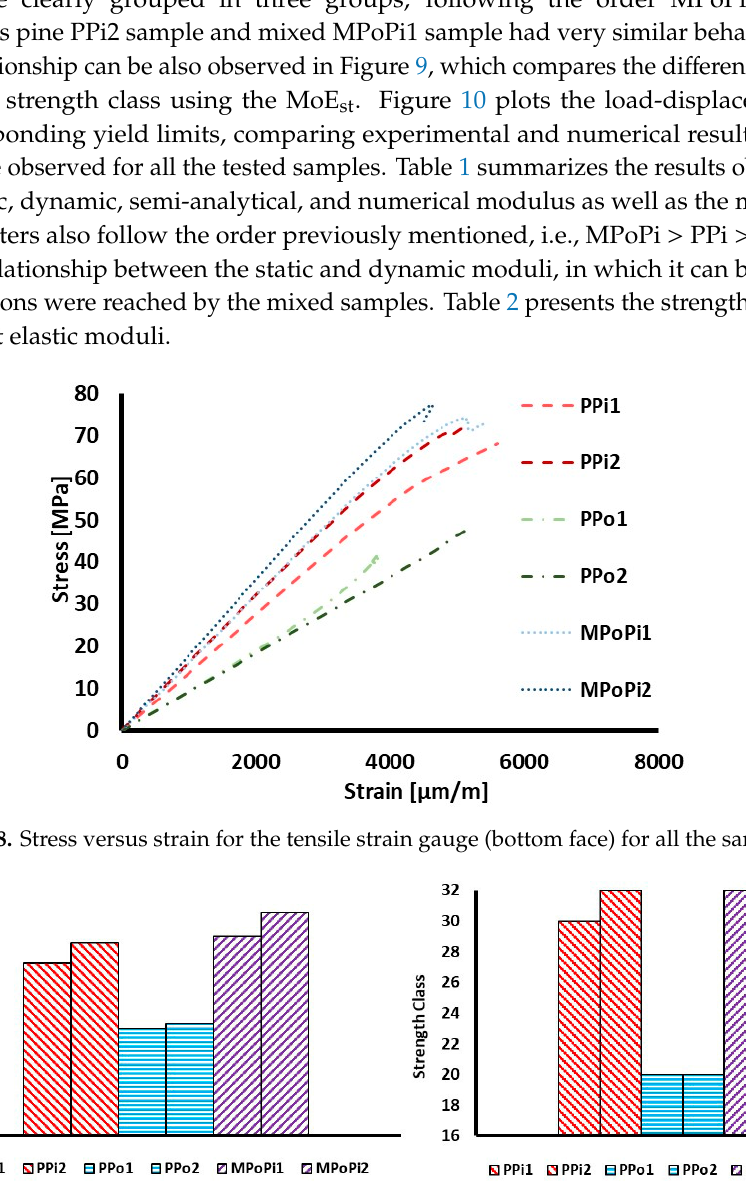
Figure 9. General results for the tested samples. Left: Static modulus of elasticity (MoE st ). Right: Strength grading of the samples with MoE st .